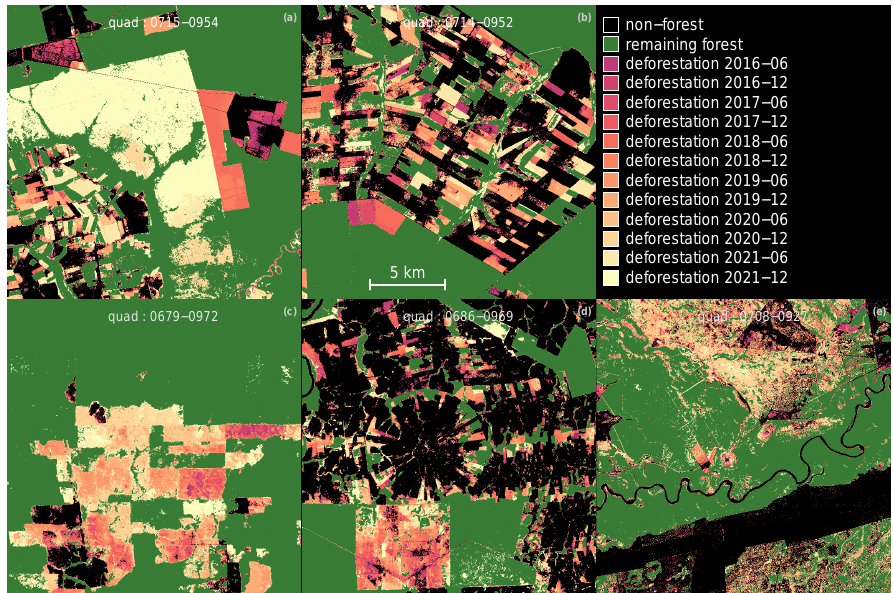
Figure 5. Example of our deforestation product for planet quads in the Xingu region ( a , b ), in a recent deforestation front between the Mato Grosso and Amazonas states ( c , d ) and in the South Central region of Mato Grosso ( e ) on the period from 1 December 2015 to 1 December 2021.